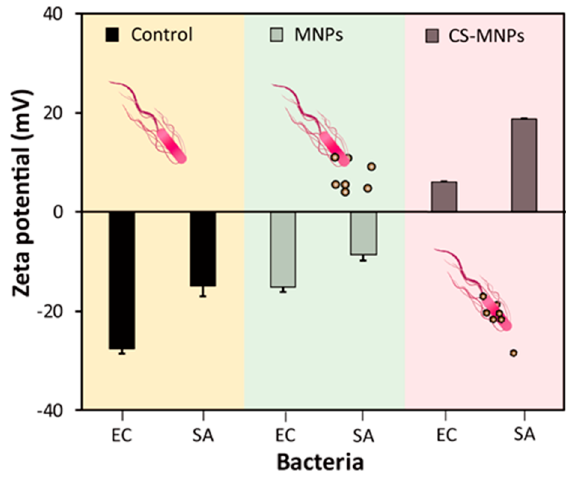
Figure 7. Zeta potential analyses of bacteria only, bacteria with bare MNPs, and bacteria with CS-MNPs. E. coli (EC) and S. aureus (SA) were used in the experiments.